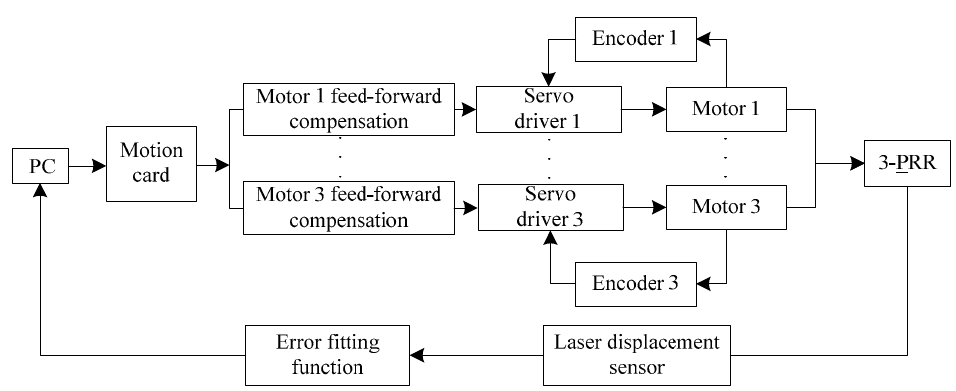
Figure 9. Schematic diagram of feed-forward control with the error fitting function.